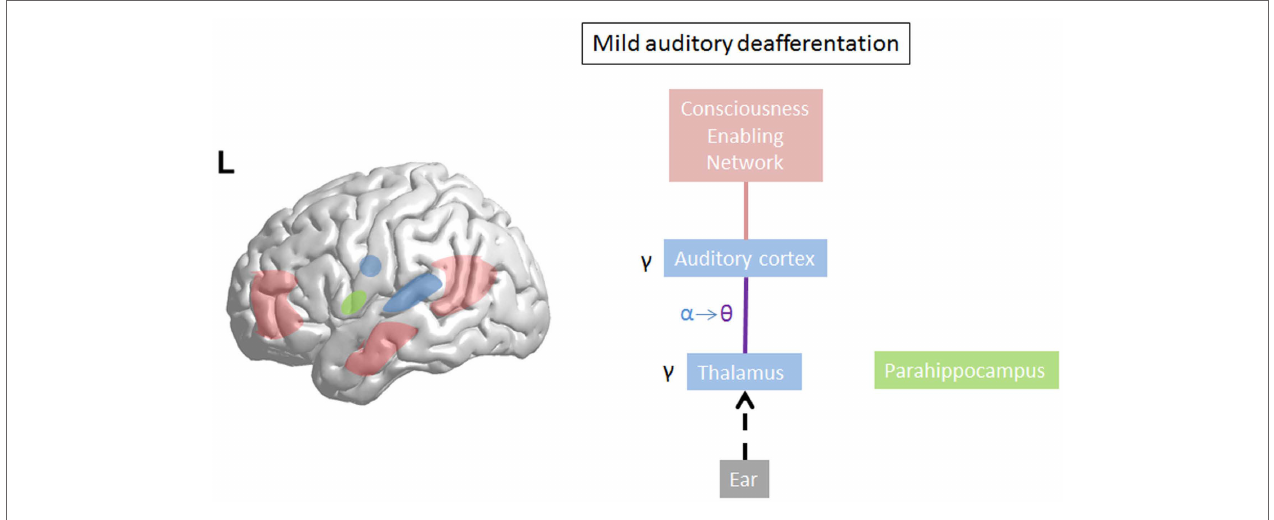
FiGuRe 3 | On limited deafferentation thalamocortical resting state alpha activity slows down to theta activity resulting in a decreased surround inhibition, so that the missing auditory information can be